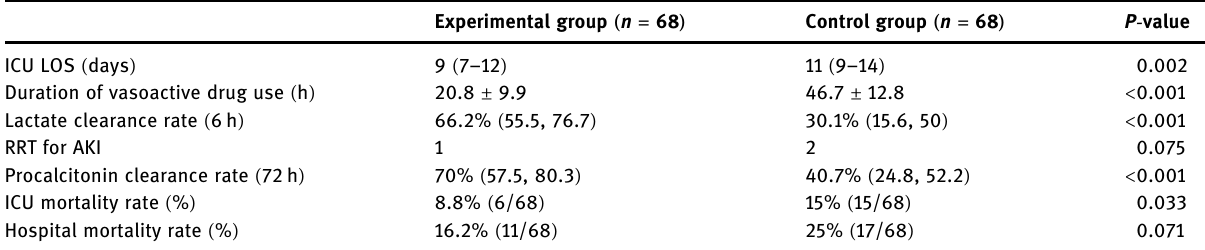
Table 2: Outcome and treatment